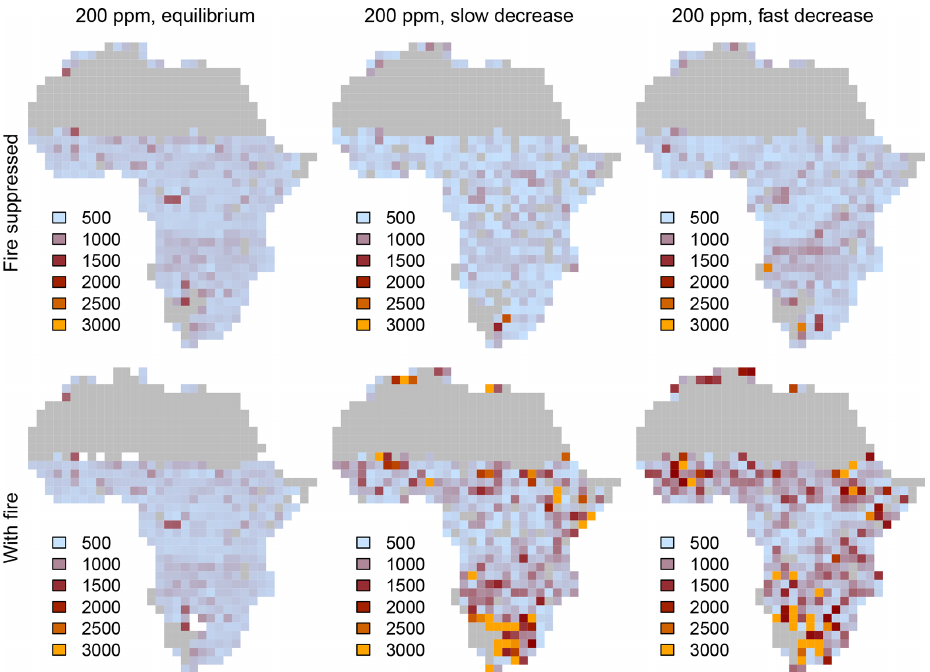
Figure 6. Time required to reach equilibrium in equilibrium simulations and transient simulations with both slow and fast decreases in CO 2 . Note that 3000 years in the legend means ≥ 3000 years, because simulations were run for a maximum of 3000